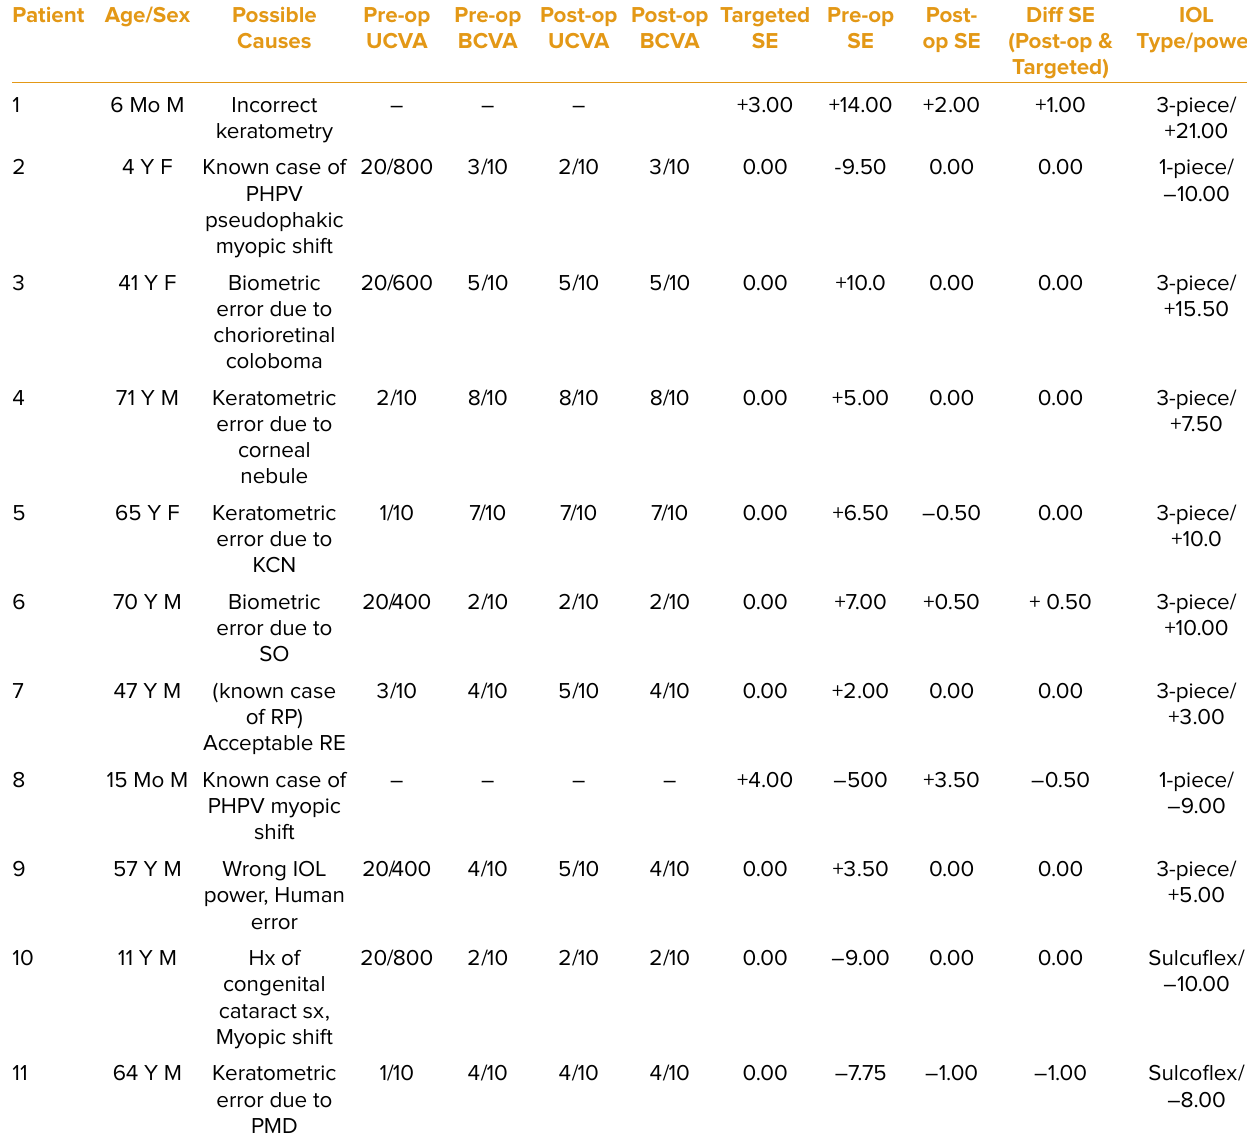
Table 4. Indications, clinical outcome, and type of implanted IOL in the study participants Patient